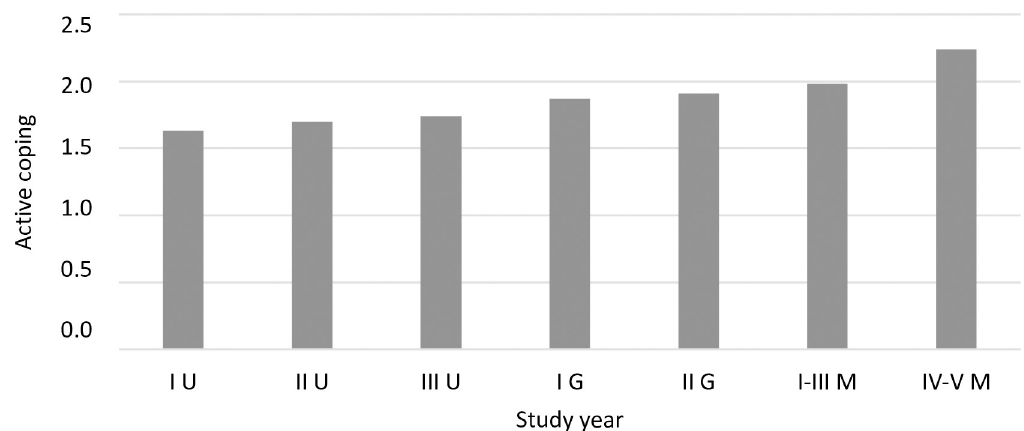
Fig 3. The coping strategy of active coping (mean) among students in individual program years (F = 5.72, p < 0.001, eta = 0.06). I U–I Undergraduate (n = 142), II U–II Undergraduate (n = 100), III U–III Undergraduate (n = 104), I G–I Graduate (n = 66), II G–II Graduate (n = 70), I-III M–I-III uniform Master’s studies (n = 64), IV-V M–IV-V uniform Master’s studies (n = 31).